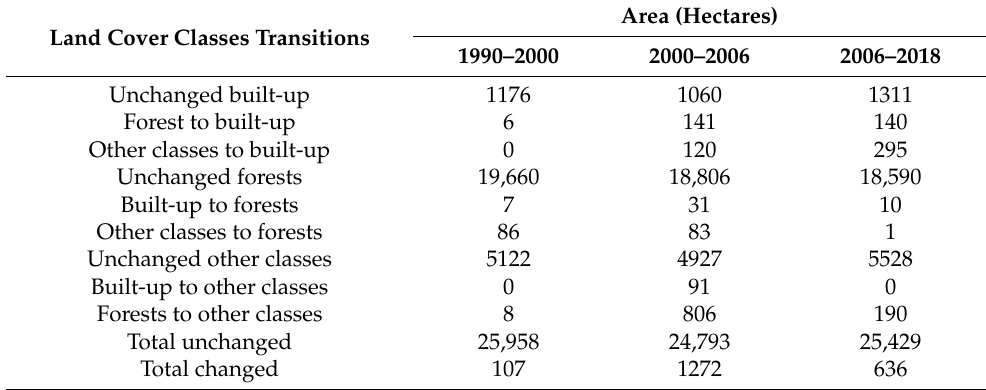
Table 2. Reclassified land cover classes transition areas dynamics between 1990 and